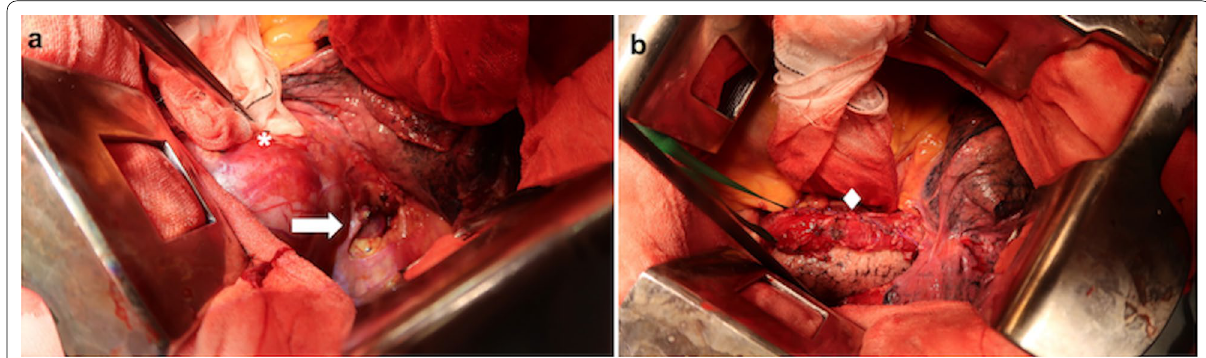
Fig. 2 Intraoperative findings. A large posterior mediastinal tumor is visible. Gauze was applied to the point of rupture and hemorrhage ( a ) (asterisk). Mediastinal pleura incised to reveal an intact esophagus ( a ) (arrow). B After tumor resection, the esophagus was conserved and repaired with suture ( b ) (diamond)